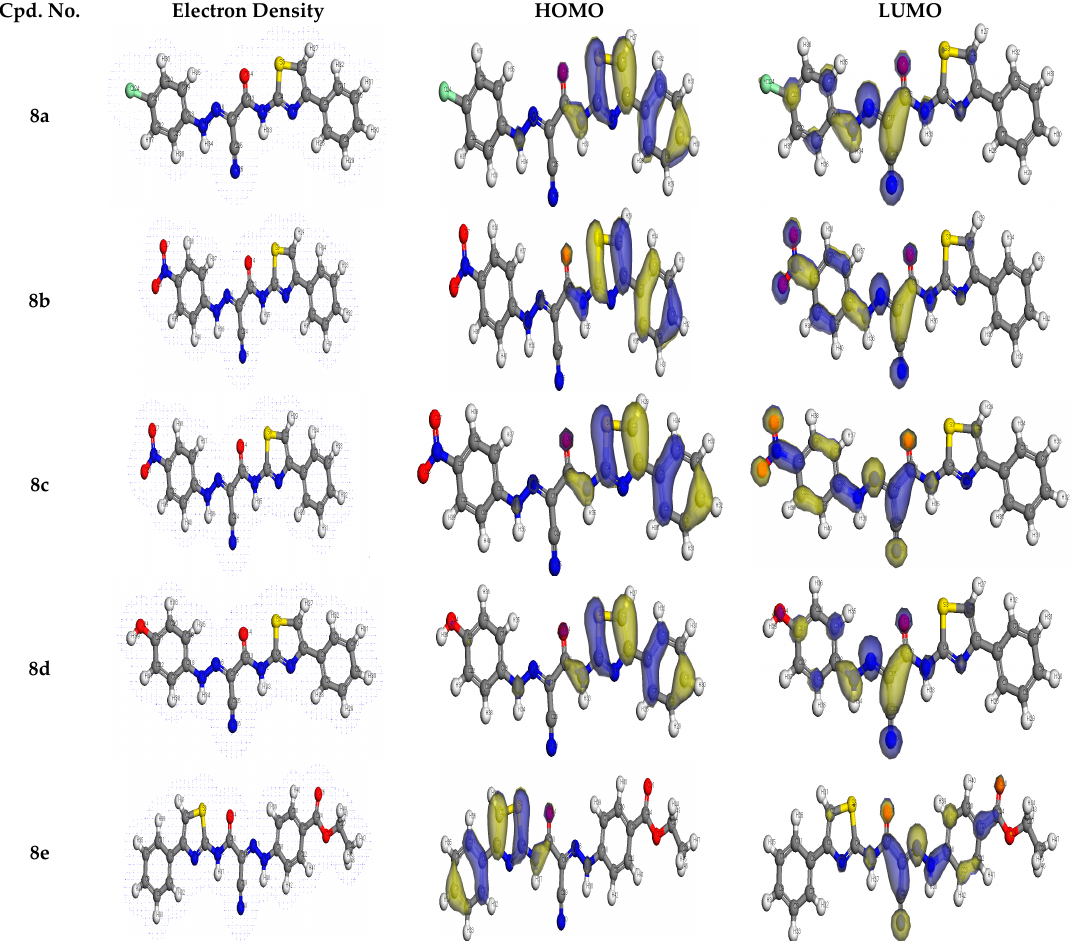
Figure 2. The electron density, the HOMO and LUMO frontier orbitals of N -(thiazol-2-yl)-2- arylhydrazono-2-cyanoacetamides 8a – e .